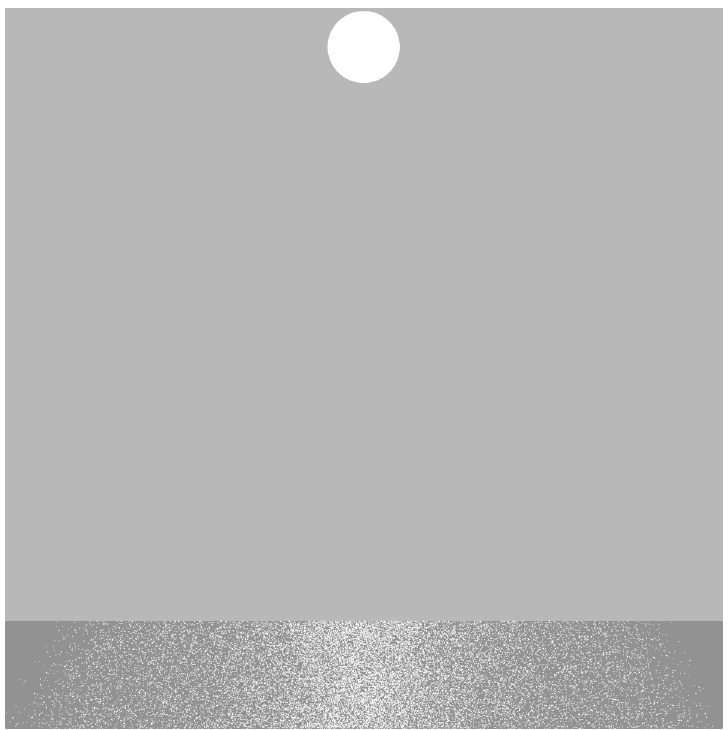
FIG. 6: Numerical simulation of the reflection at finite angle of incidence of a light-emitting disc by a surface of